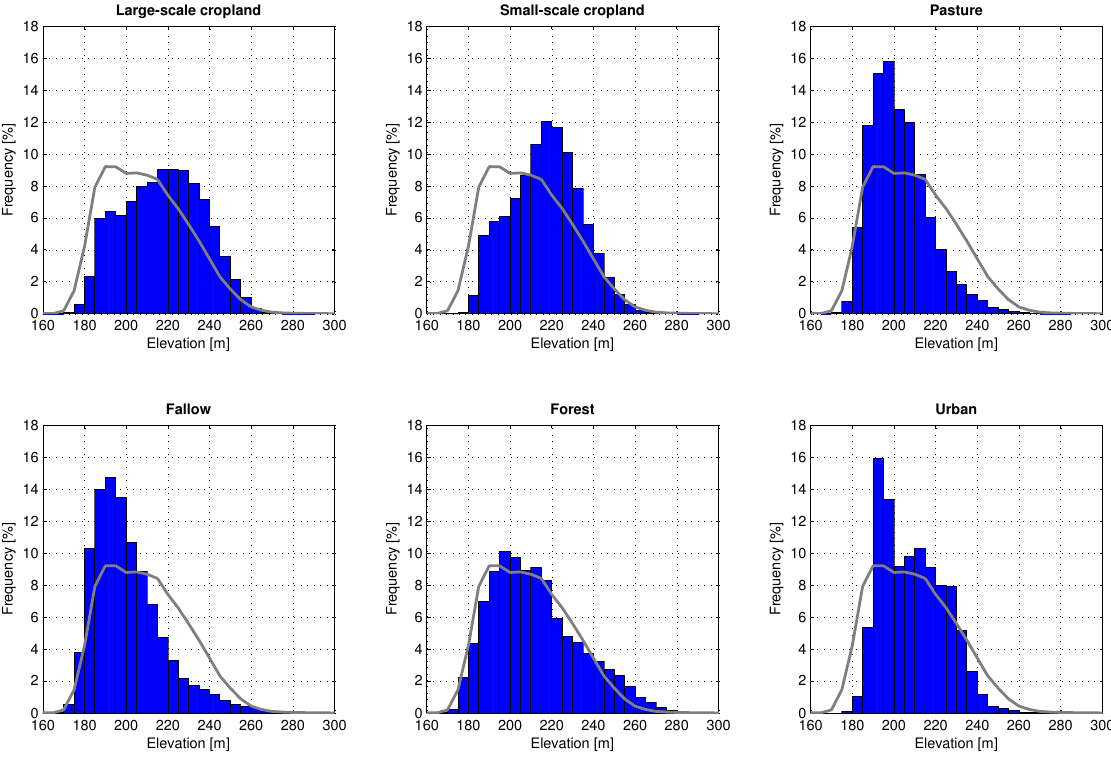
Figure 9. Histogram showing the distribution of each class in dependency of the elevation; Grey lines show the overall distribution of the elevation in the study